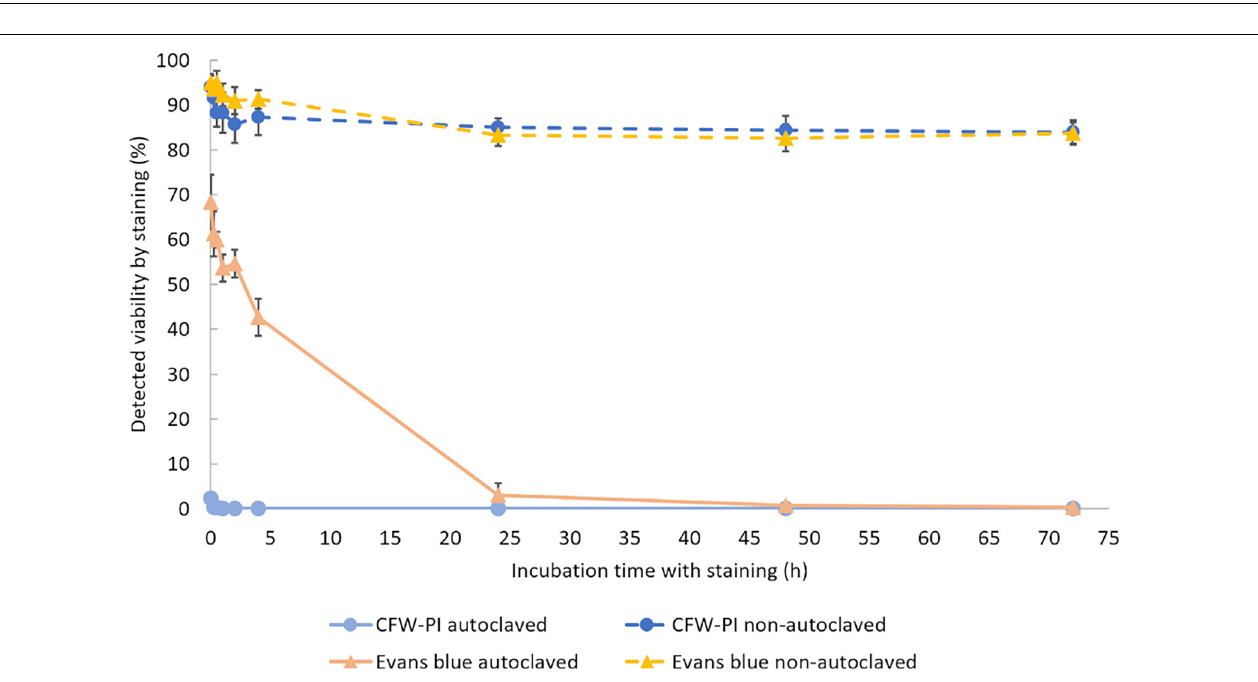
FIGURE 3 | Confocal laser scanning microscopy (CLSM) images of Plasmodiophora brassicae resting spores double stained with calcofluor white (CFW)–propidium iodide (PI). Both dead and viable spores appear blue after CFW staining, while the nuclei of dead spores appear red after PI staining. In the merged image, the blue spores indicate viability and the pink spores are dead. BF, bright field.